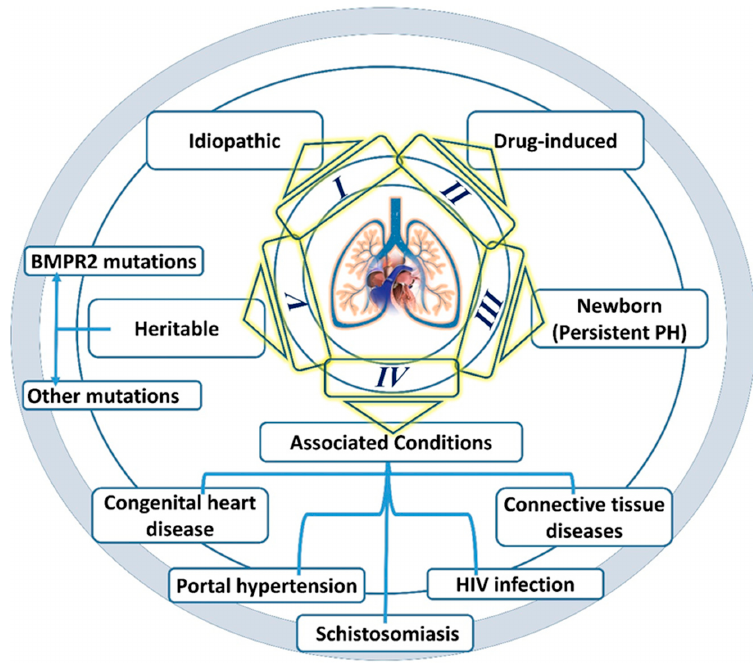
Figure 1. Classification of pulmonary arterial hypertension.